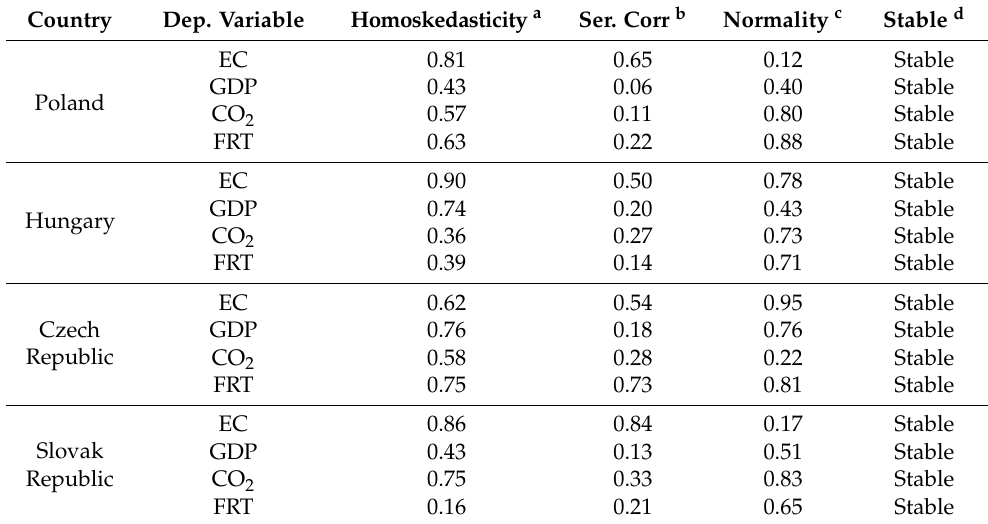
Table 8. Diagnostic tests of estimated models ( p